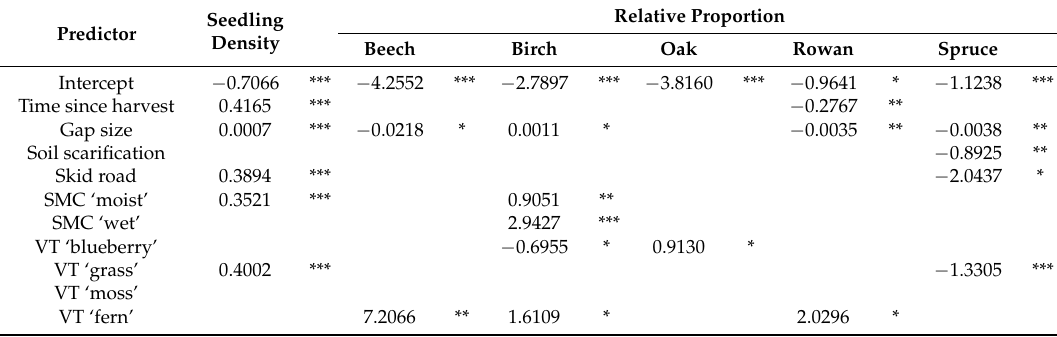
Table 7. Parameter estimates and significance levels of predictor variables including various soil moisture classes (SMC) and vegetation types (VT) of generalized linear mixed effects models for regeneration subplot-level total seedling density and relative species-specific proportion.